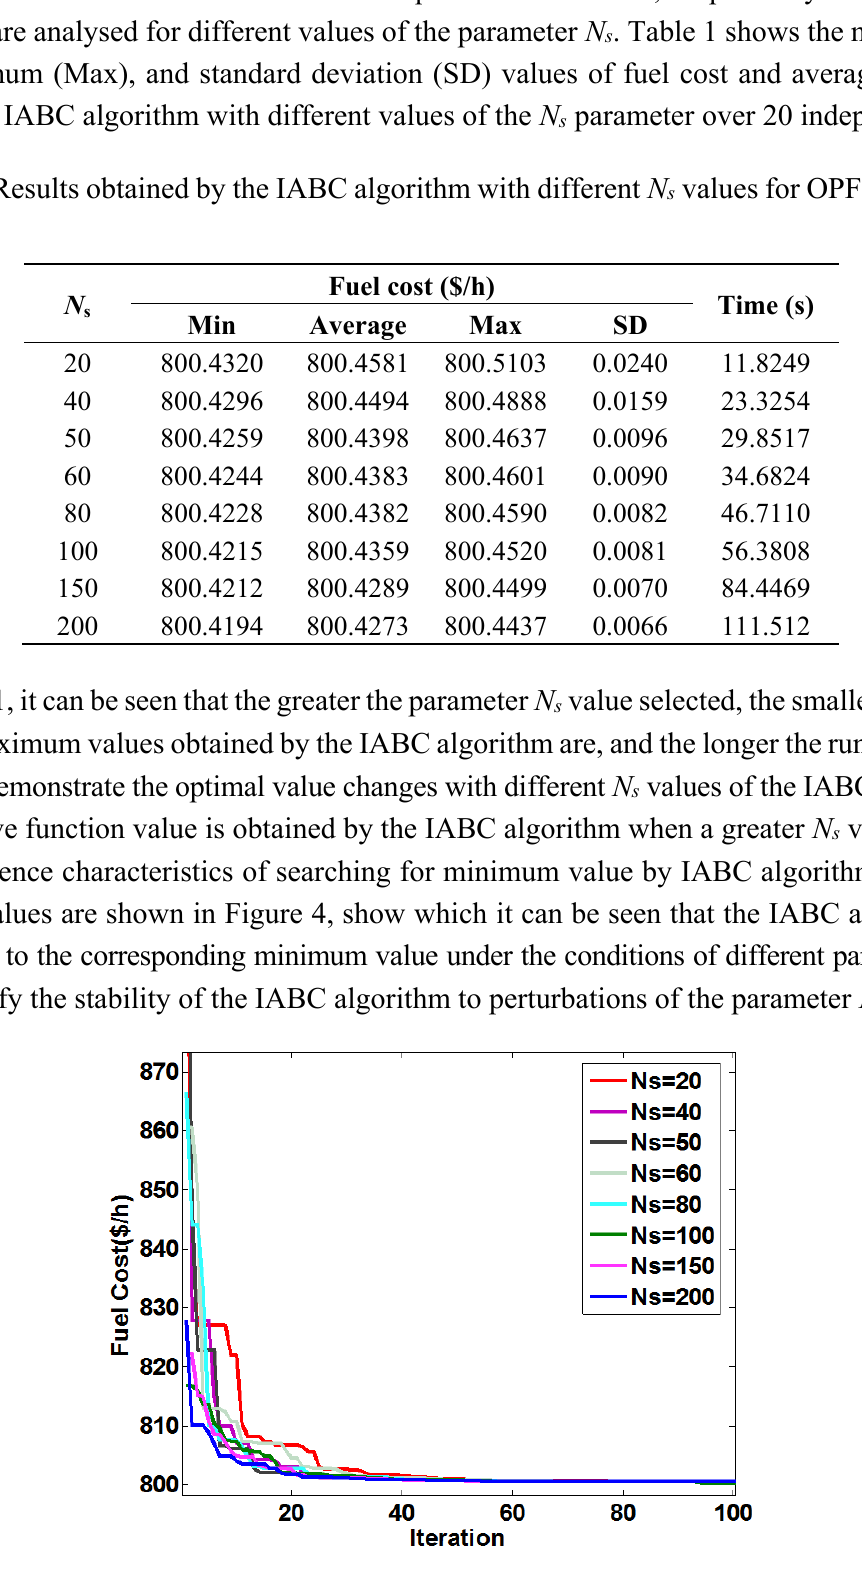
Figure 4. Convergence characteristics obtained by the IABC algorithms with different values of the parameter N s for OPF with total fuel